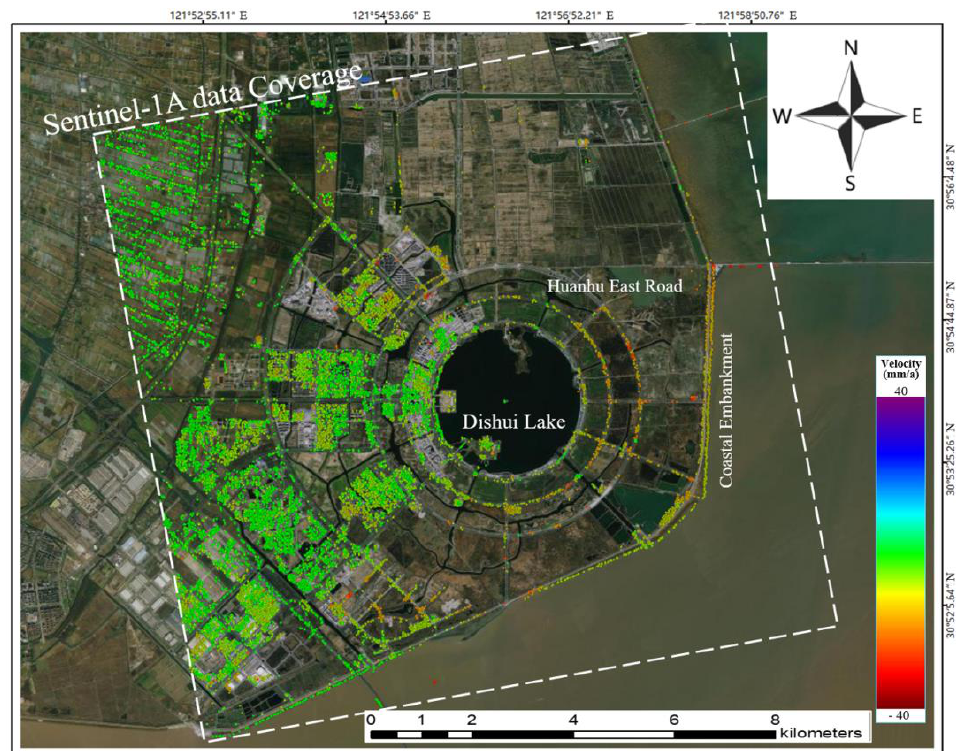
Figure 4. The map of the deformation rate map of Shanghai Lingang New City.